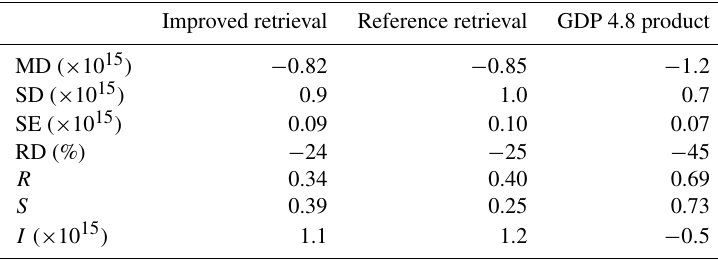
Table B4. Similar to Table B1 but for the background OHP station for a total of 106 monthly